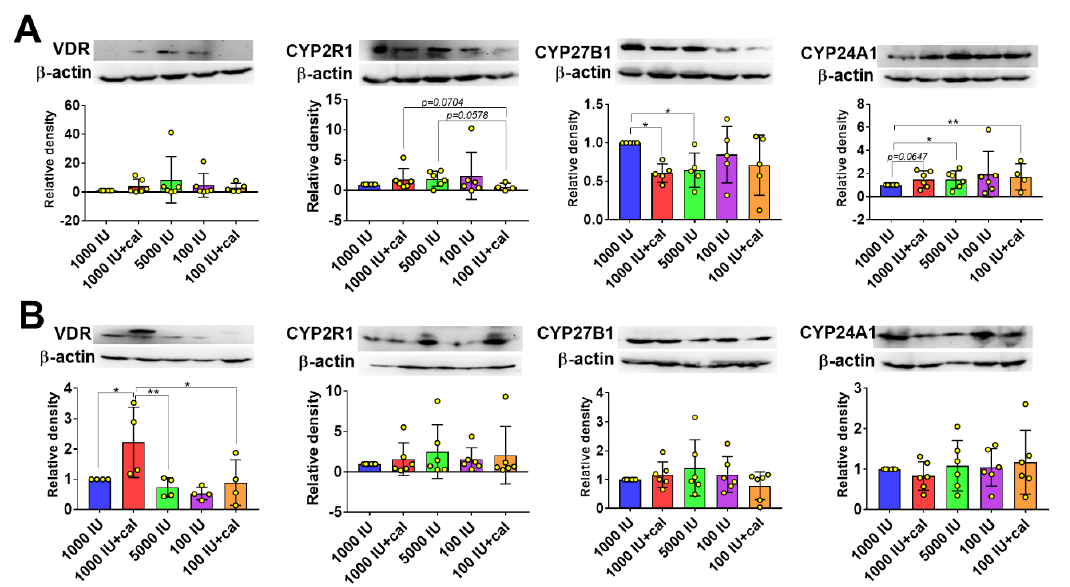
Figure 8. Expression of VDR, CYP2R1, CYP27B1, and CYP24A1 in the tissues of healthy C57BL / 6 mice. Expression of proteins in the ( A ) kidney and (B ) liver. N = 4–6 mice per group. Densitometric analysis was performed using ImageJ software. Results are normalized to β -actin and next to the control group (1000 IU). Data are presented as mean with standard deviation; individual data are also presented as yellow points. Tissue from 4–6 mice / group was analyzed. Statistical analysis: Sidak’s test for multiple comparisons. * p < 0.05; ** p < 0.01.